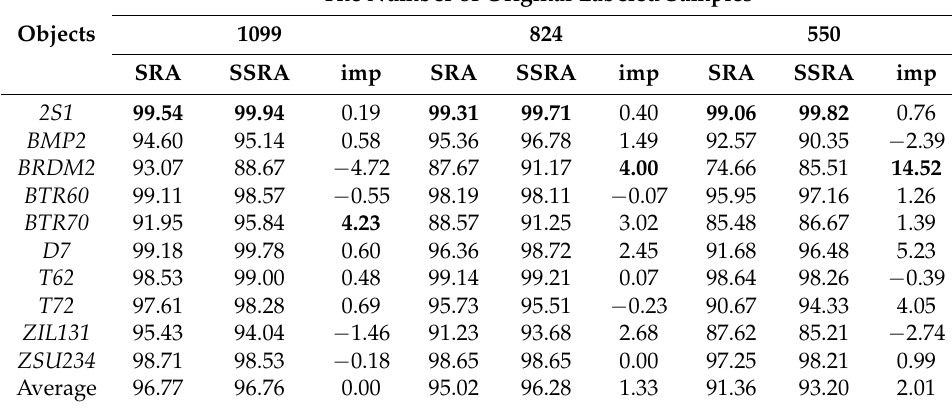
Table 5. Recognition accuracy (%) and relative improvements (%) obtained with our semi-supervised learning method with different number of original labeled samples. The best accuracies are indicated in bold in each